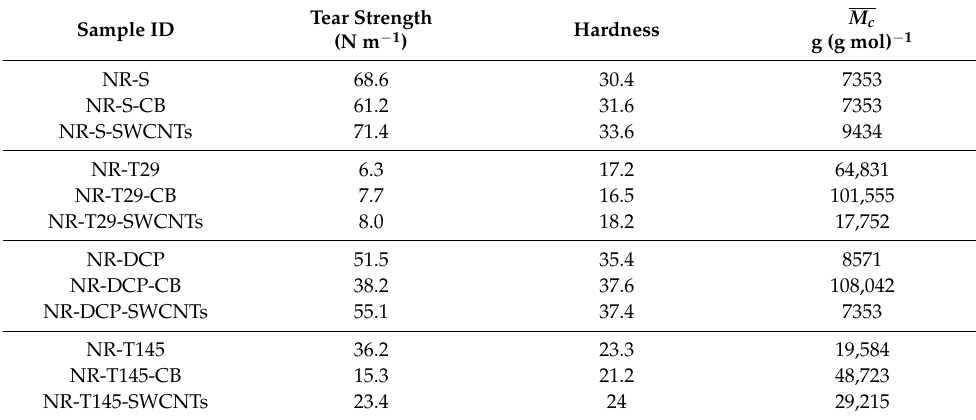
Table 6. Values of tear strength, hardness, and M c obtained for NR